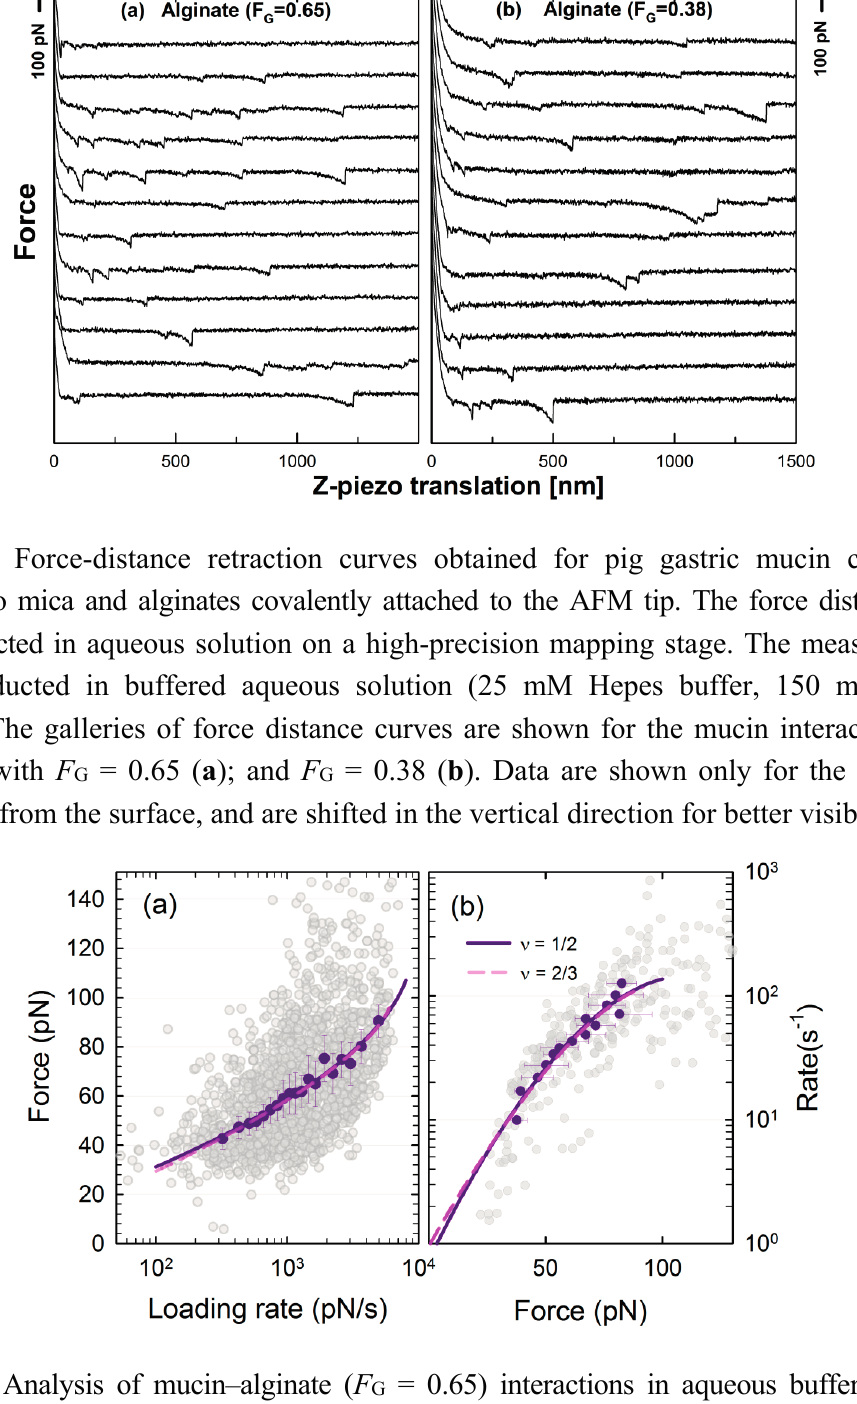
Figure 8. Analysis of mucin–alginate ( F G = 0.65) interactions in aqueous buffer (25 mM Hepes, 150 mM NaCl, pH 6.9) using mean rupture force versus loading rate ( a ) and dissociation rate versus rupture force ( b ) representation. The data is presented as individual dissociation events (transparent symbols for each unbinding event) and the mean value of rupture force versus loading rate (Figure 8a) and mean dissociation rate versus rupture force (Figure 8b). The mean values are calculated within the sub–distributions. The continuous lines depict the fits according to Equation (1) (Figure 8a) or Equation (2) (Figure 8b) for the energy barriers with ν = 1/2 and ν = 2/3. Two examples of histograms for the sub-distributions in Figure 8a are shown in Figure